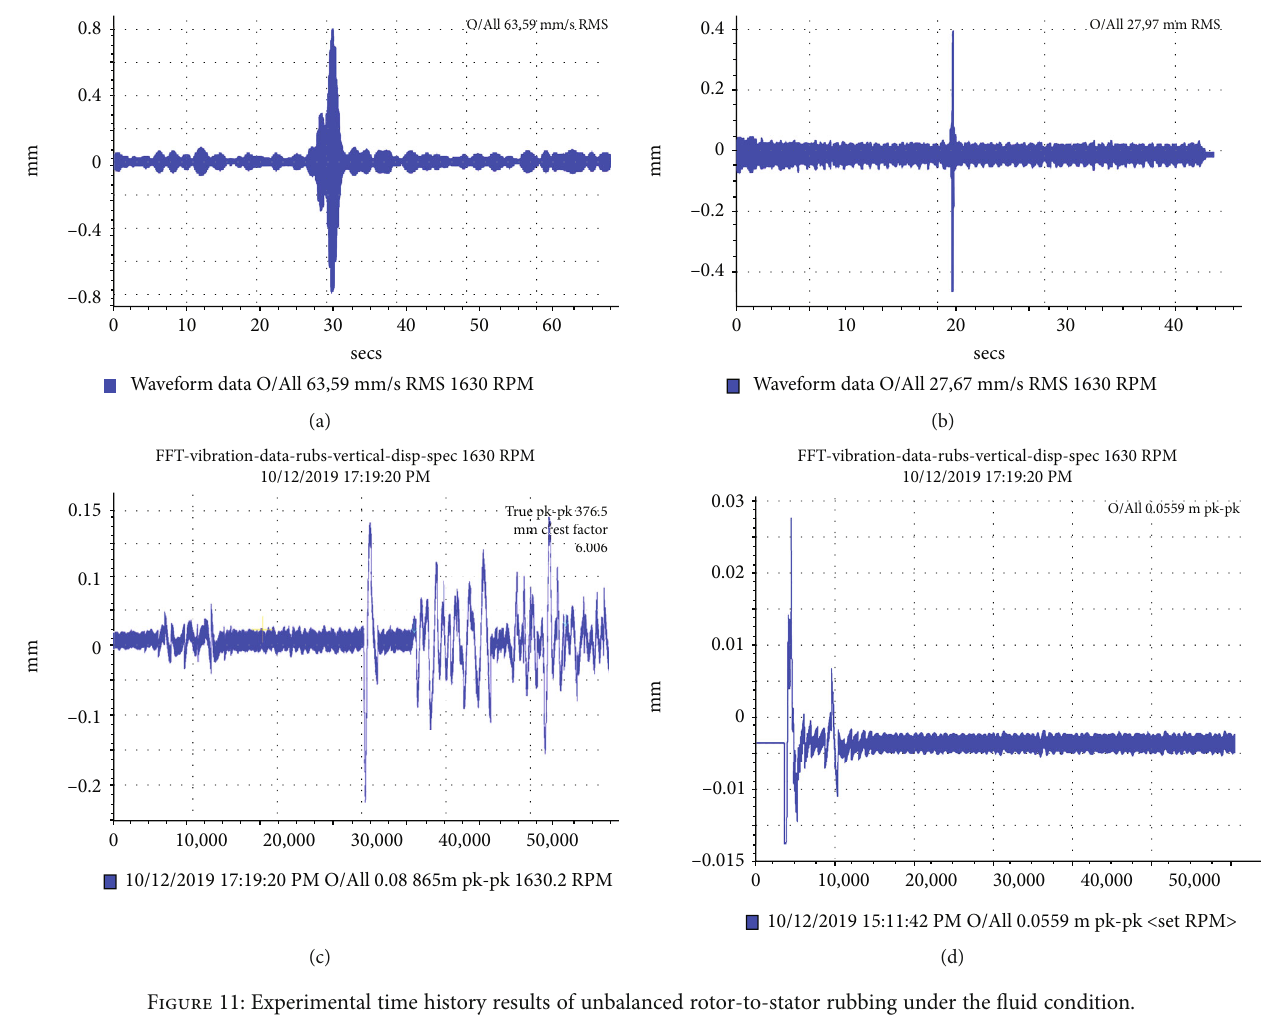
Figure 11: Experimental time history results of unbalanced rotor-to-stator rubbing under the fl uid condition.